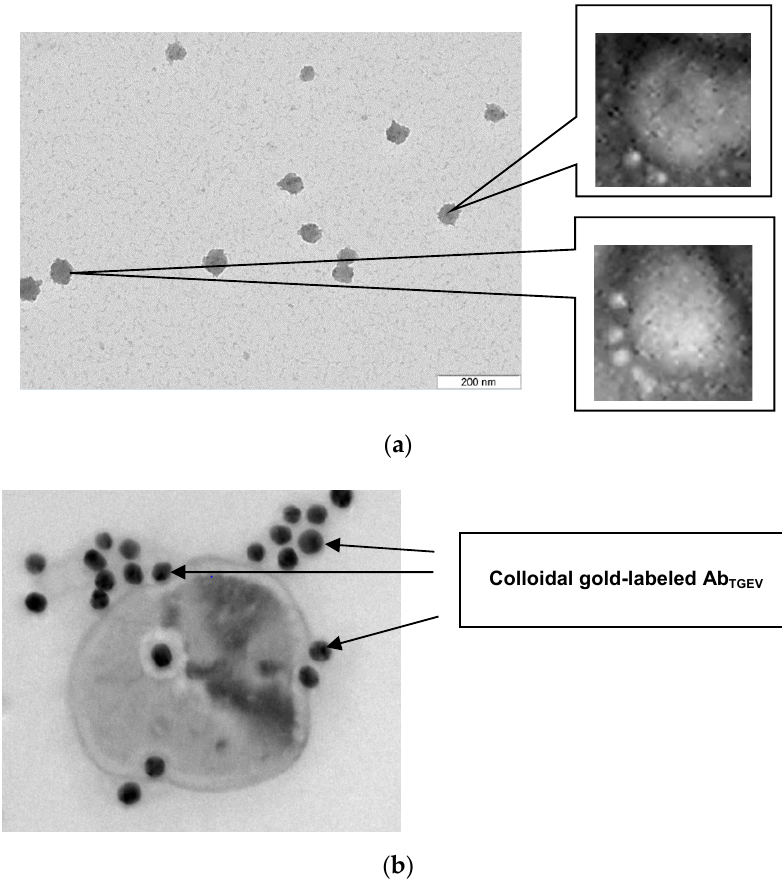
Figure 6 . Transmission electron microscopy (TEM) data of TGE viruses: ( a ) without specific Abs and ( b ) with Ab TGEV labeled with colloidal gold (×10,000). The scale is 100 nm (the zoom is equal to 40,000).